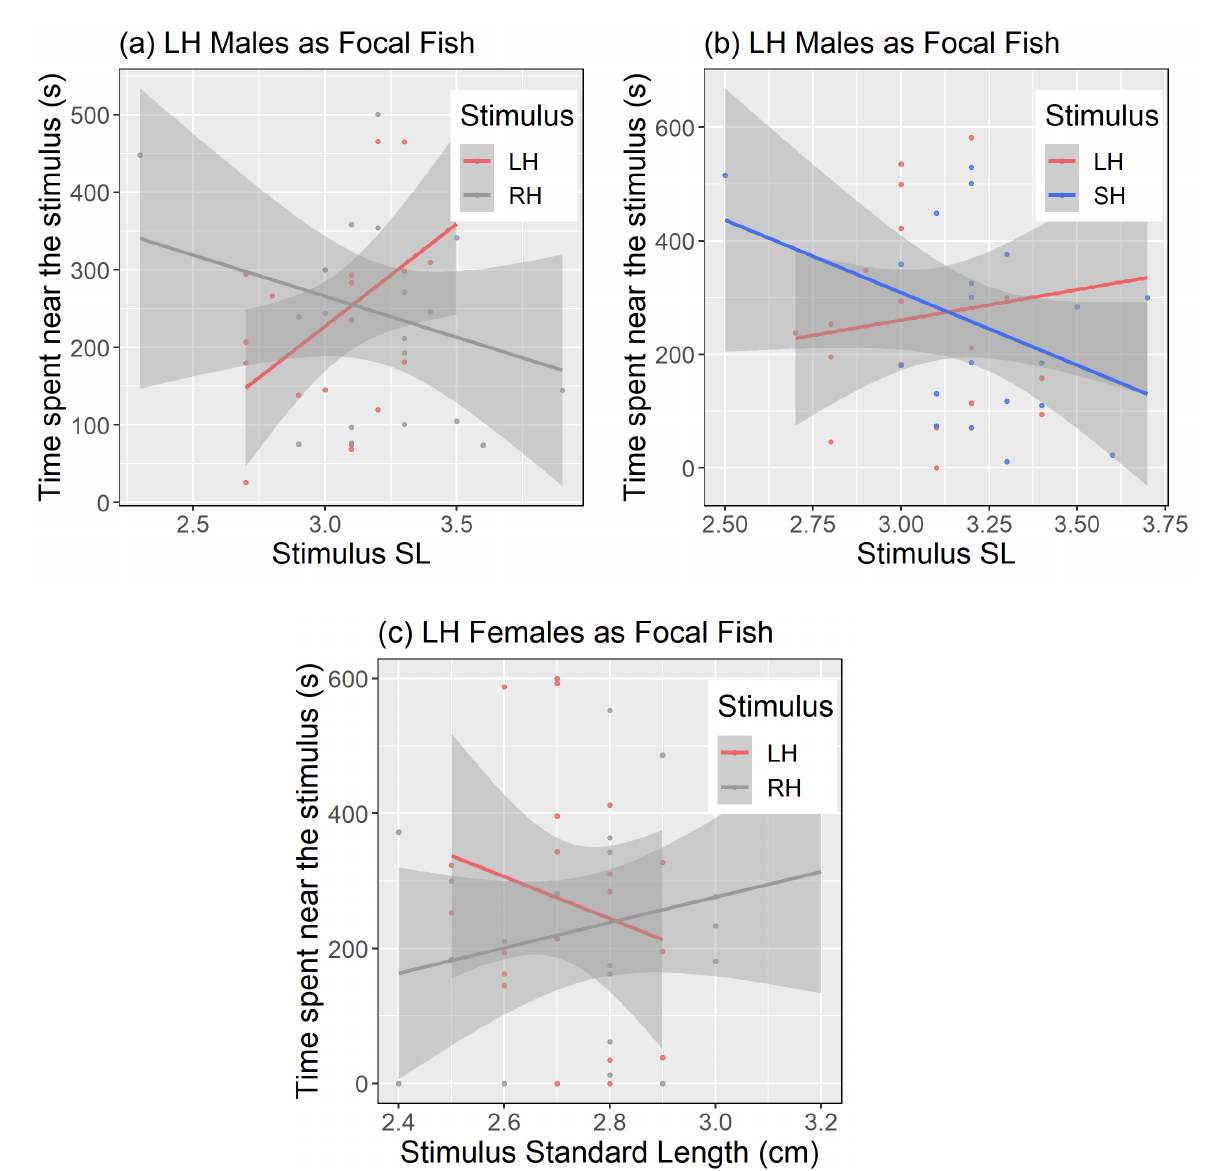
Figure 4. Interactions of body size (SL) of stimulus fish and time spent by LH male ( a , b ) and LH female ( c ) focal fish near stimulus fish. Shaded areas spanning the regression lines represent confidence intervals. SL = Standard length; LH = Large-harvested; RH = Random-harvested; SH = Small-harvested.